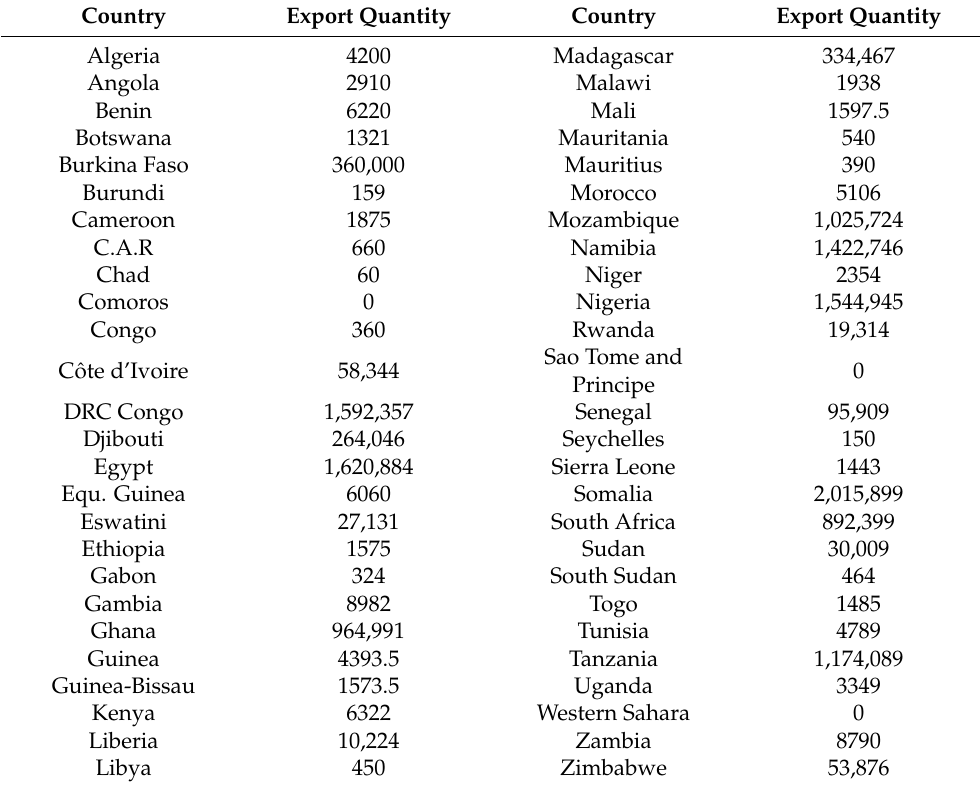
Table 3. Wood charcoal export (in tonnes) by African countries for three decades